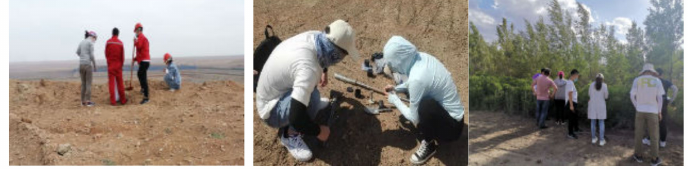
Figure 8. Sampling.